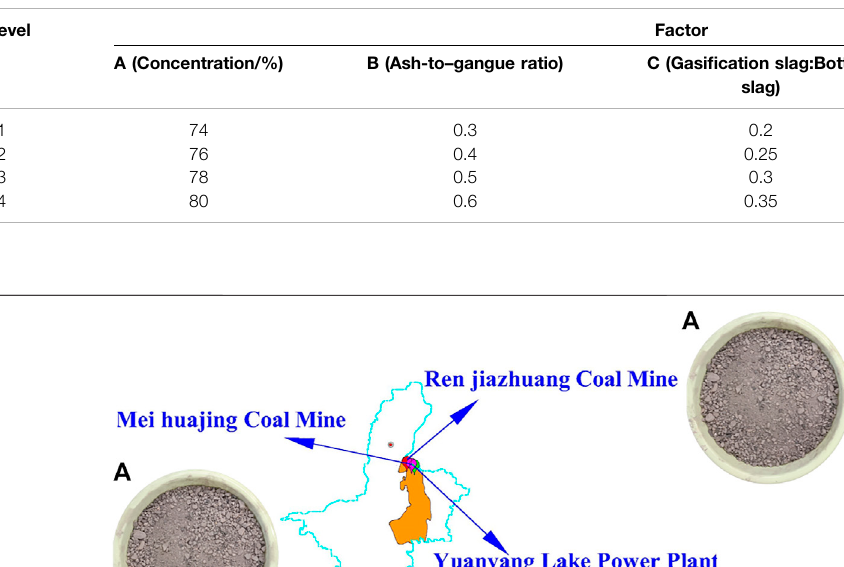
TABLE 1 | L16 (4 4 ) orthogonal experimental factors and levels.